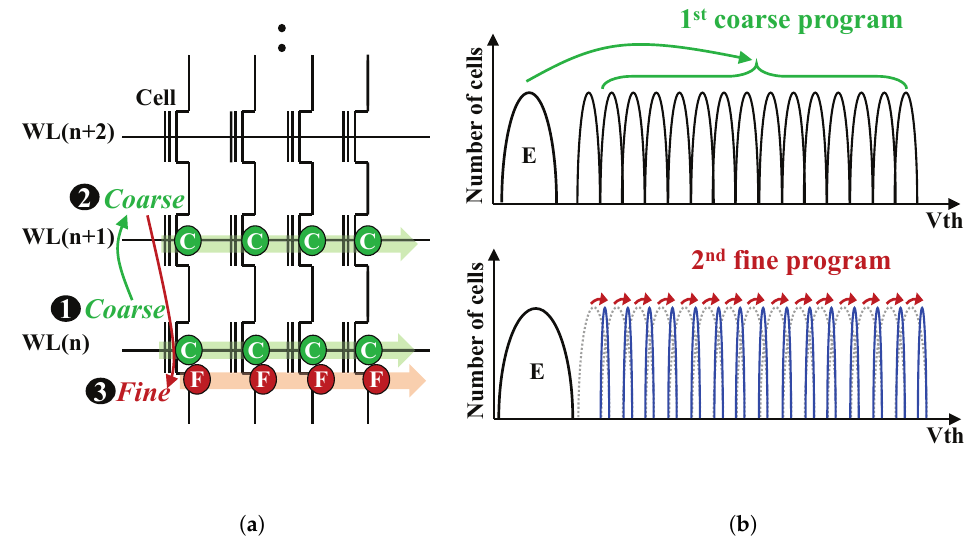
Figure 3. An example of a two-step QLC reprogram scheme. ( a ) Reprogramming sequence. ( b ) V th distribution of